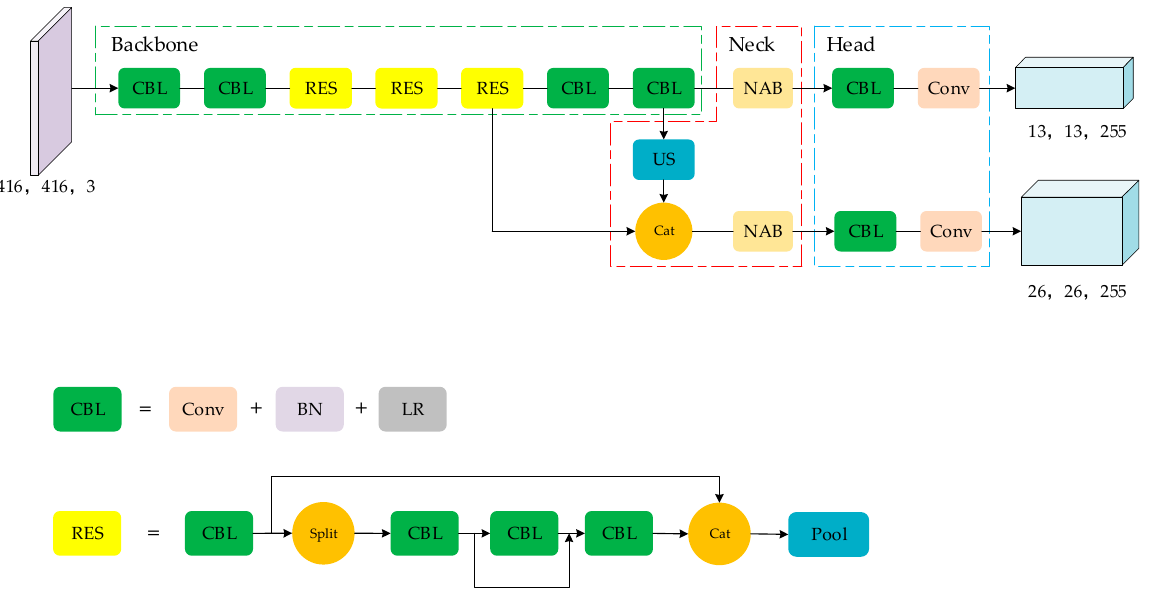
9 of 18 Figure 5. The network of the improved SSD. ‘Conv_1~3 ′ is the first three blocks of VGG16.